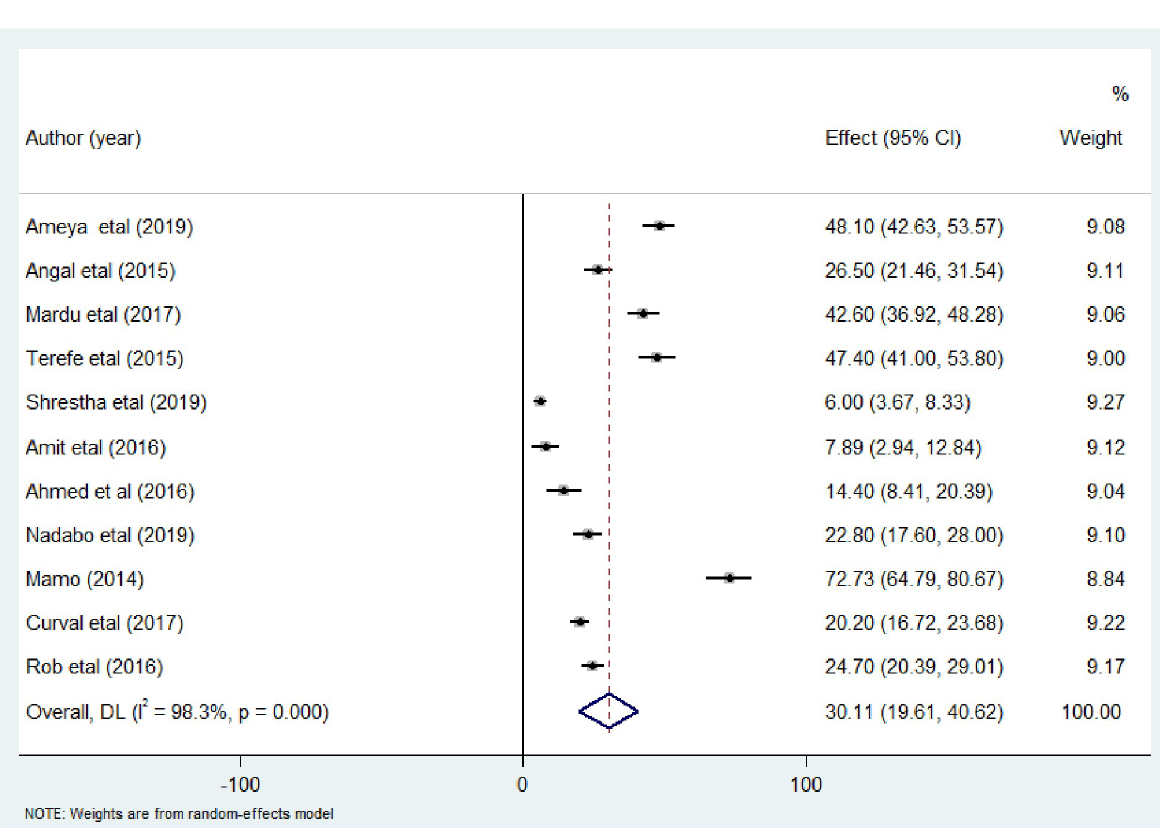
Fig 3. Forest plot showing the pooled prevalence of intestinal parasitic infection among prison